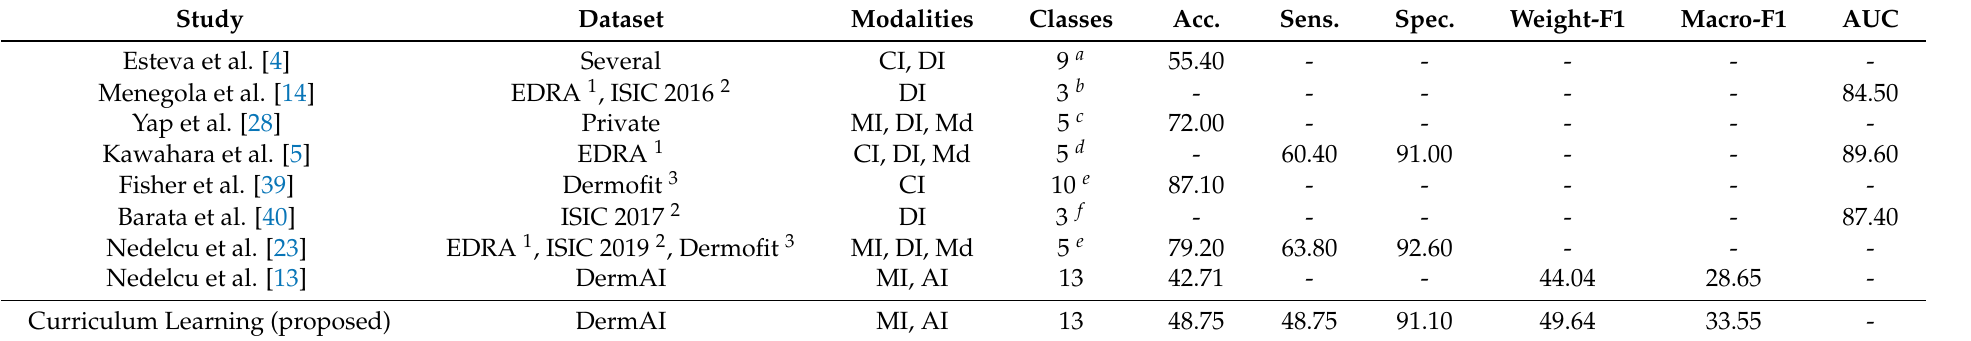
Table 8. Results concerning some related skin lesion diagnosis